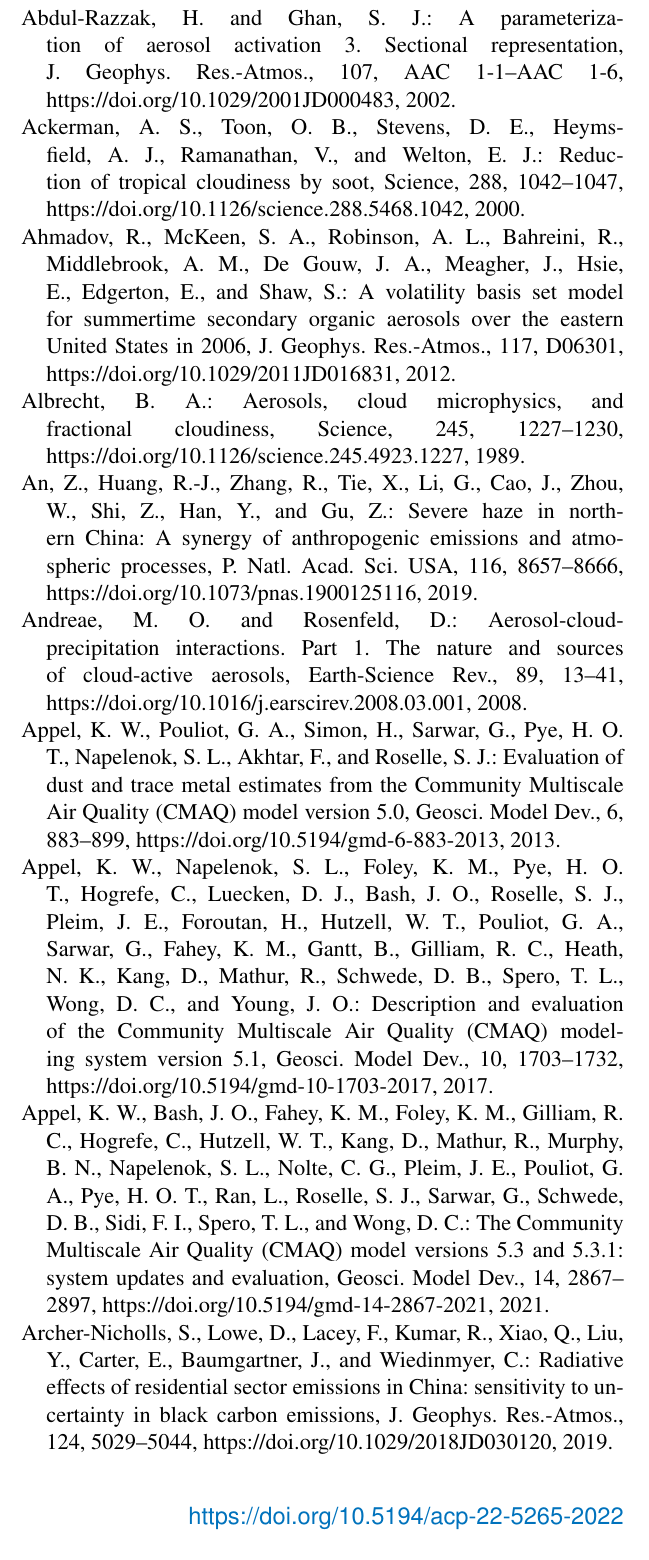
(Table S2), quantitative effects of aerosol feedbacks on meteorolog- ical and air quality variables (Table S3), model configuration and setup (Table S4), and aerosol-induced variations of simulated short- wave and longwave radiative forcing (Table S5) extracted from col- lected studies of applications of two-way coupled meteorology and air quality models in